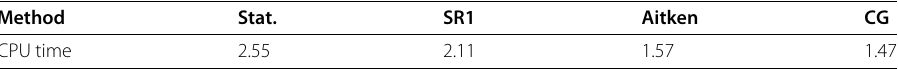
Table 2 CPU time for various methods in the full linear case Method Stat. SR1 Aitken CG CPU time 2.55 2.11 1.57